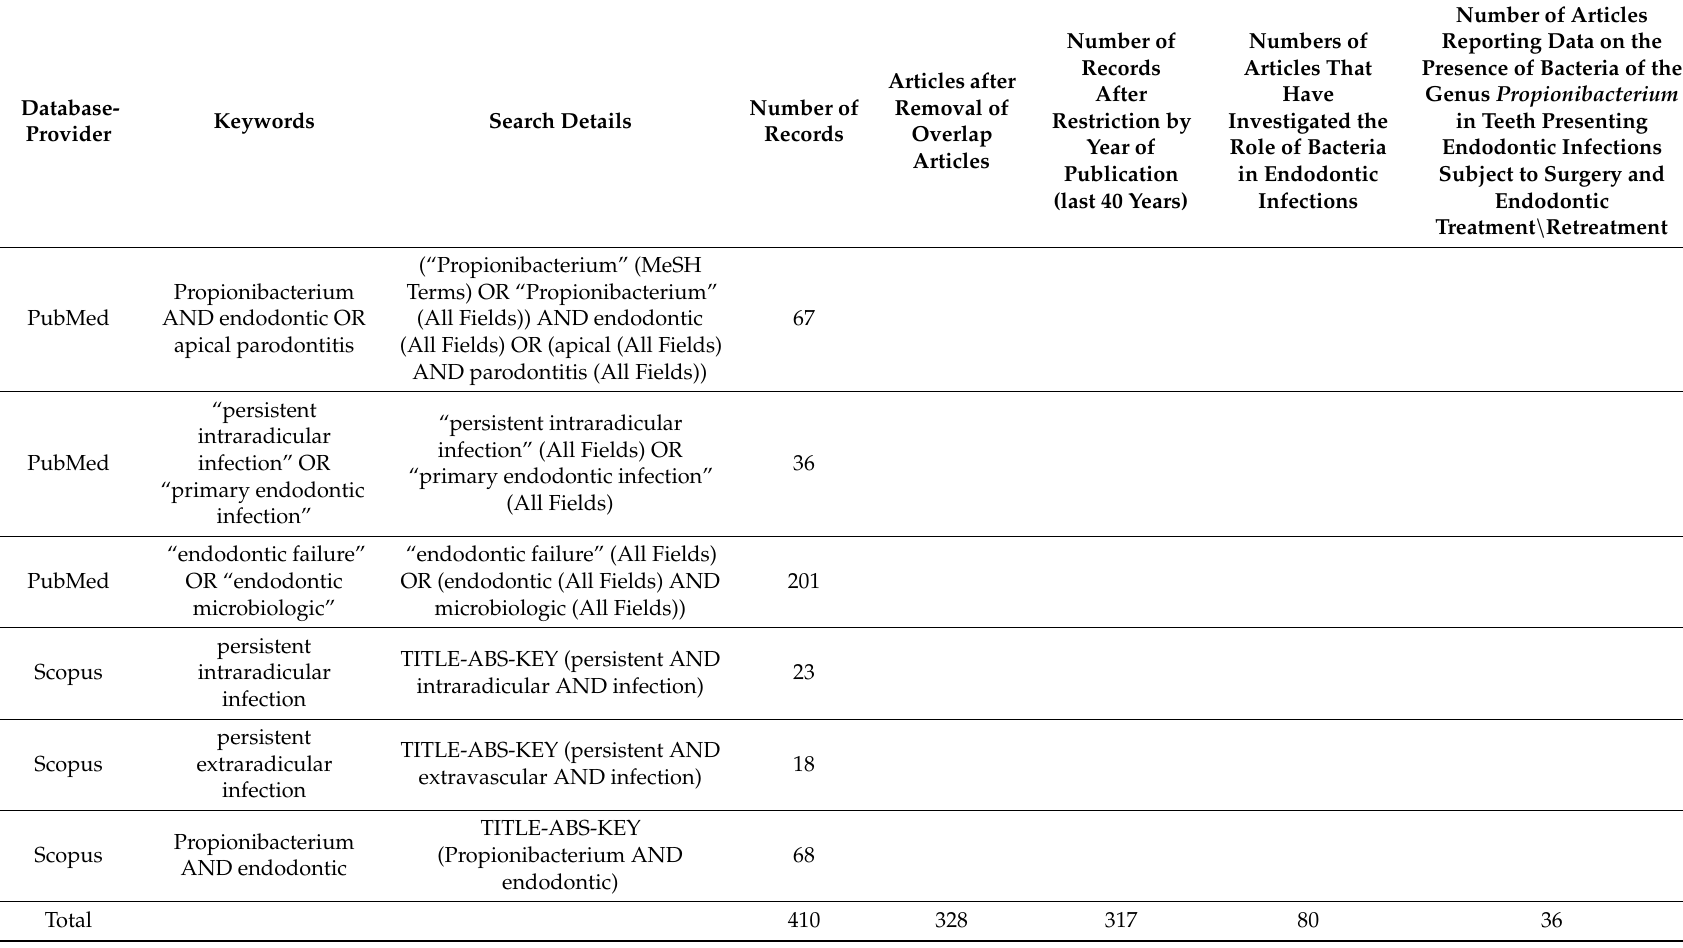
Table 1. Complete overview of the search methodology. Records identified by databases: 410 and records selected for quantitative analysis: 36.